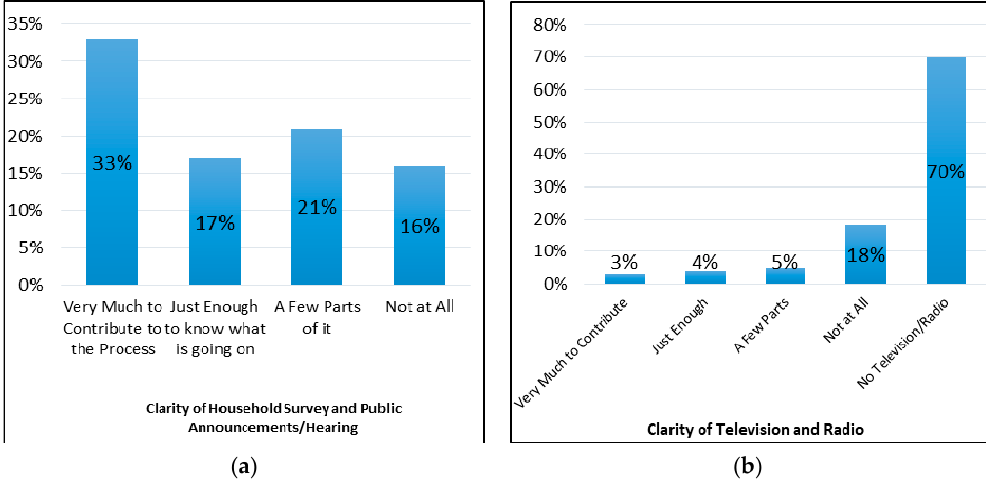
Figure 3. How clear was the information through these media? ( a ) Household survey/public announcement/hearing; ( b ) television/radio (n = 38).